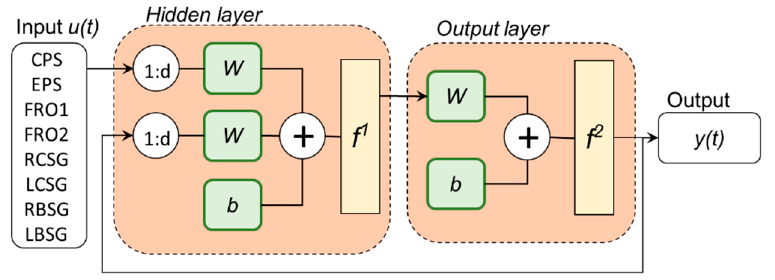
Figure 2. NARX neural network structure. d is order delay. W is the network input vector and the feedback vector weight matrix. b is bias. f 1 is the neural network hidden layer activation function. f 2 is the neural network output layer activation function [35].